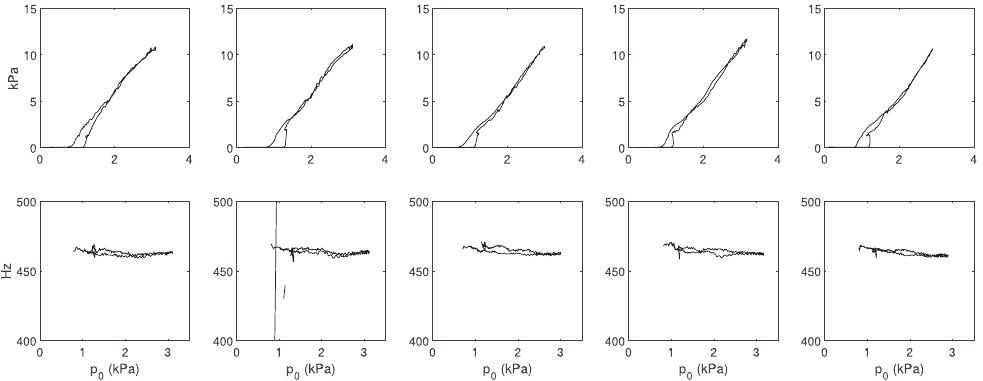
Figure 7. Experimental bifurcation diagrams obtained from one player playing a Bb4 with slow crescendo-decrescendo. Top: | p e | with respect to (cid:2) p 0 . Bottom: f 0 with respect to (cid:2) p 0 e e